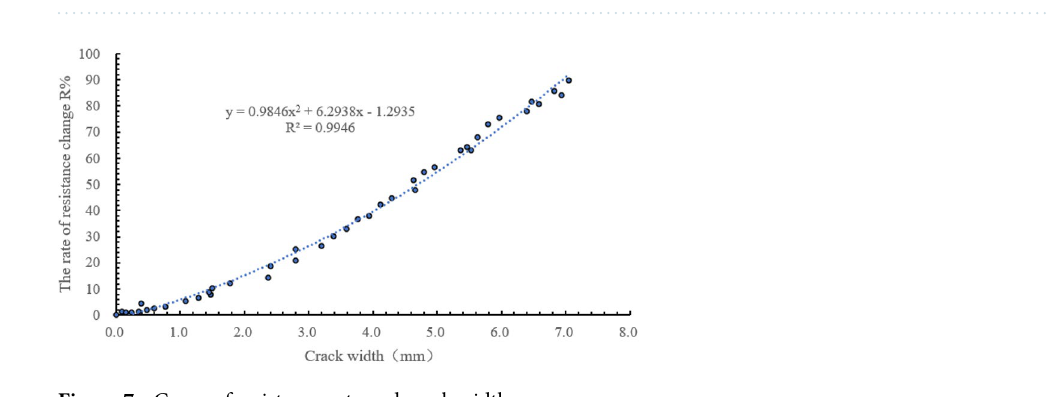
Figure 7. Curve of resistance rate and crack